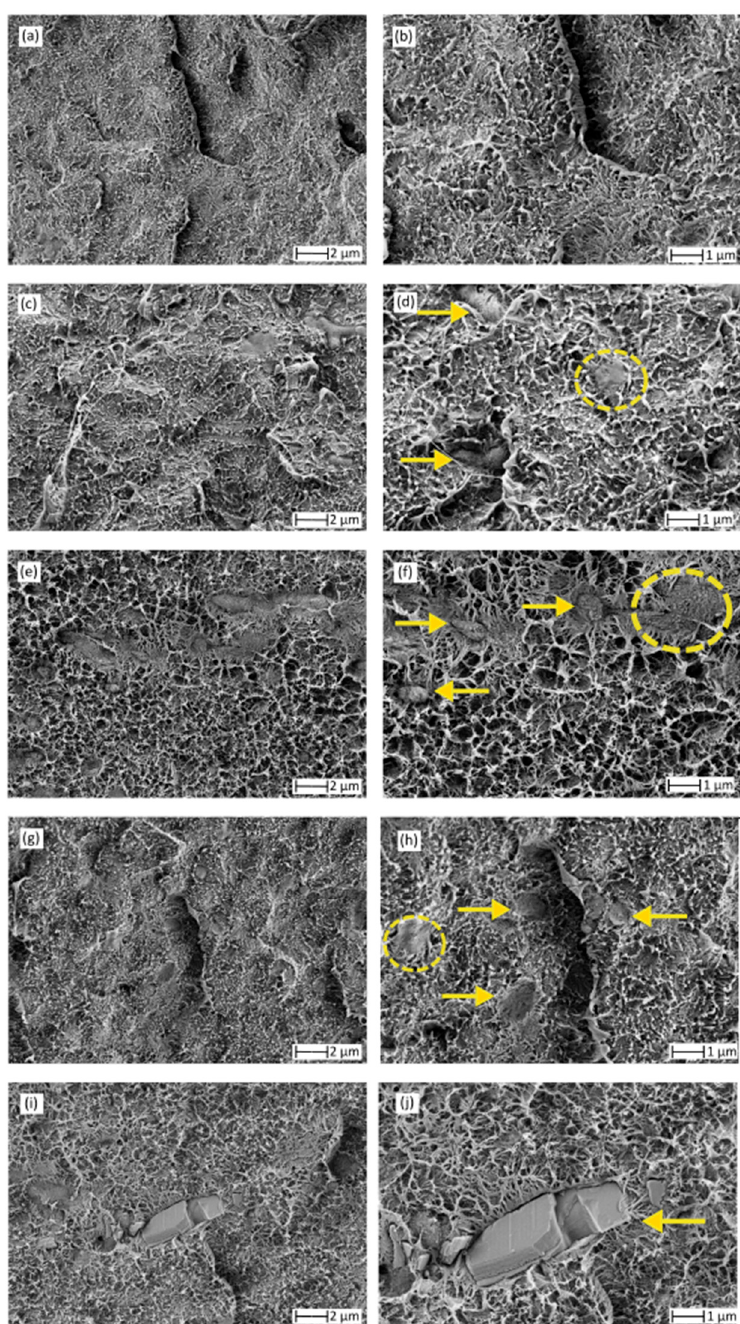
Figure 3. Field emission scanning electron microscopy (FESEM) micrographs of the cryo-fracture surfaces of the thermo-compressed films of: ( a , b ) neat bio-based high-density polyethylene (bio- HDPE); ( c , d ) bio-HDPE + naringin (NAR); ( e , f ) bio-HDPE + gallic acid (GA); ( g , h ) bio-HDPE + caffeic acid (CA); ( i , j ) bio-HDPE + quercetin (QUER). Left images were taken at 5000× with scale of 2 μ m and right images were taken at 10,000× with scale of 1 μ m. Yellow arrows indicate the presence of the phenolic compounds.